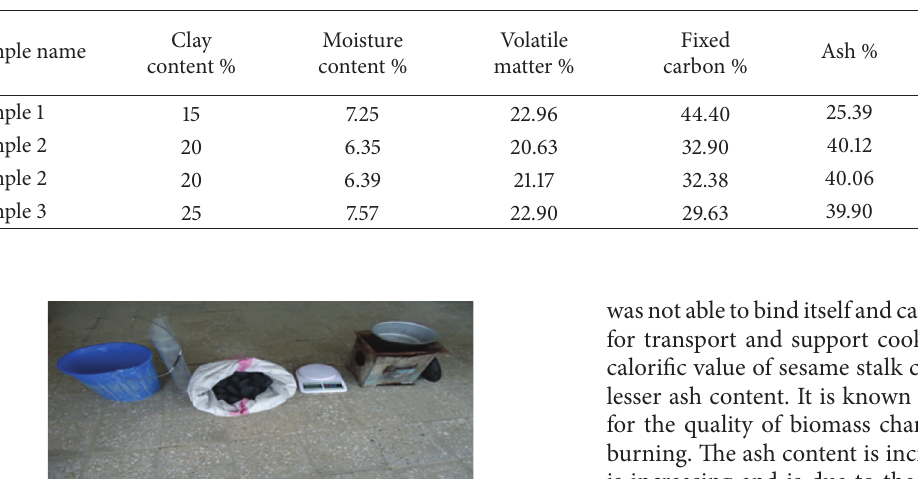
Table 5: Method of analysis: proximate analysis, adiabatic calorie meter, and eschka mixture.